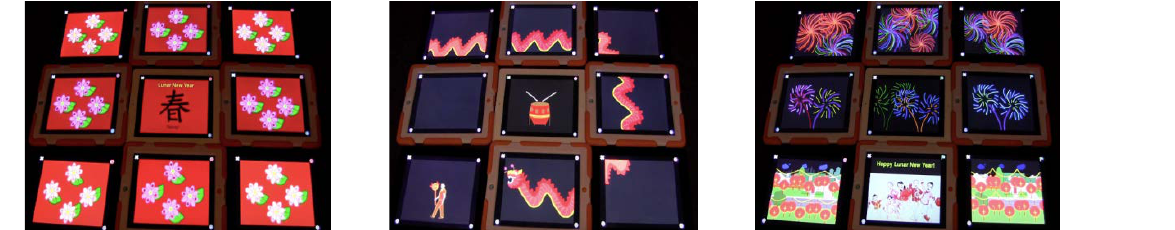
Figure 3. This image shows the Lunar New Year collaborative project